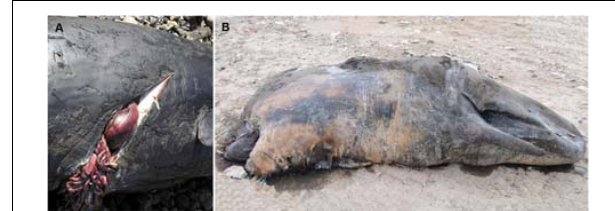
FIGURE 2 | Vessel strike-related injuries in sperm whales ( Physeter microcephalus ) stranded in the Canary Islands. (A) Presence of a deep incision in the right flank of the animal, caudal to the pectoral fin, with soft tissue exposure, abdominal perforation and evisceration and costal fractures, case 4. (B) Complete amputation of the vertebral column at the level of the last thoracic vertebrae, case 14.